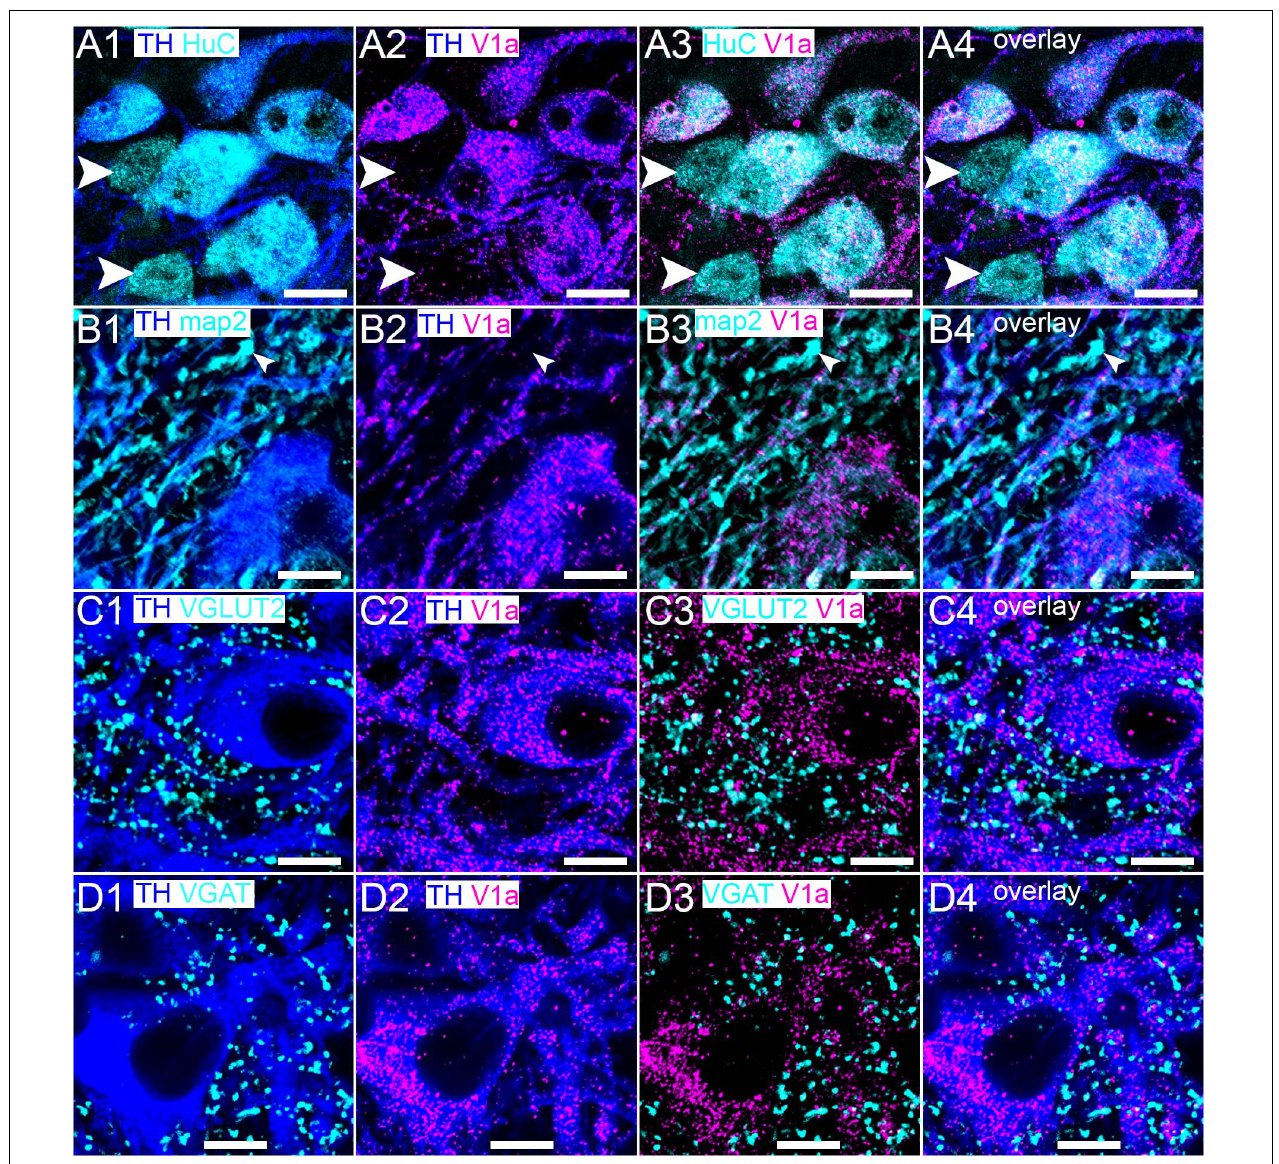
FIGURE 4 | Within the LC, the V1a receptor is expressed exclusively on noradrenergic neurons. (A1) Shows immunoreactivity for TH (blue) and HuC (cyan), with the arrowheads highlighting non-noradrenergic neurons of the LC. (A2) Shows, in the same field of view, immunoreactivity for TH (blue) and V1a receptor (magenta), confirming that its expression, within the LC, is restricted to noradrenergic neurons and (A3) is not located on non-noradrenergic neurons (arrowheads). (A4) Is an overlay of (A1–A3) . (B1) Shows immunoreactivity for TH (blue) and MAP2 (cyan) with the arrowhead highlighting a non-noradrenergic dendritic profile. (B2) shows, in the same field of view, immunoreactivity for TH (blue) and V1a receptor (magenta), which confirms V1a expression on noradrenergic profiles and (B3) not on non-noradrenergic profiles (arrowhead). (B4) Is an overlay of (B1–B3) . (C) and (D) show the association of V1a immunoreactivity with VGLUT2 and VGAT labeling respectively. Scale bars (A) 15 µ m; (B–D) 10 µ